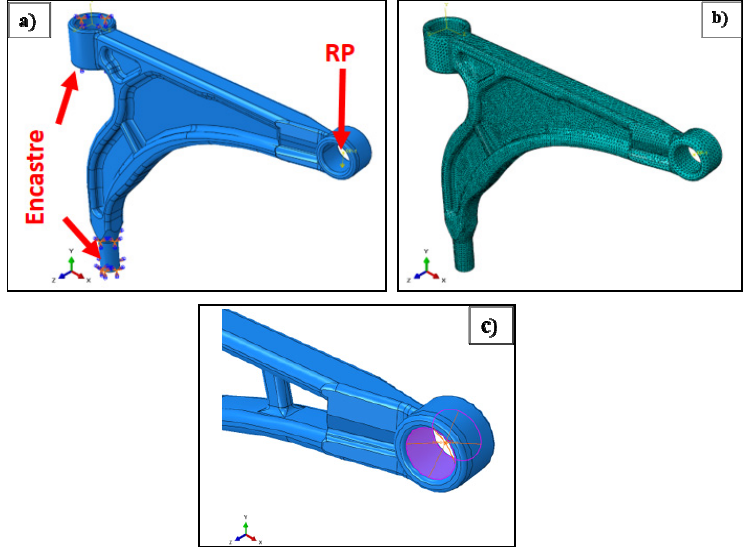
Figure 3. Finite elements configuration. ( a ) Boundary conditions, ( b ) meshing of the control arm part, and ( c ) multiple point constraint (MPC) interaction.